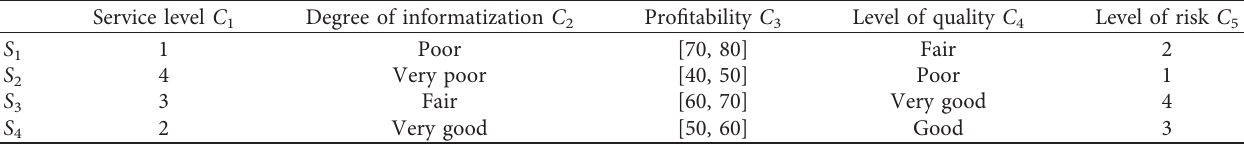
Table 1: The assessment information of the